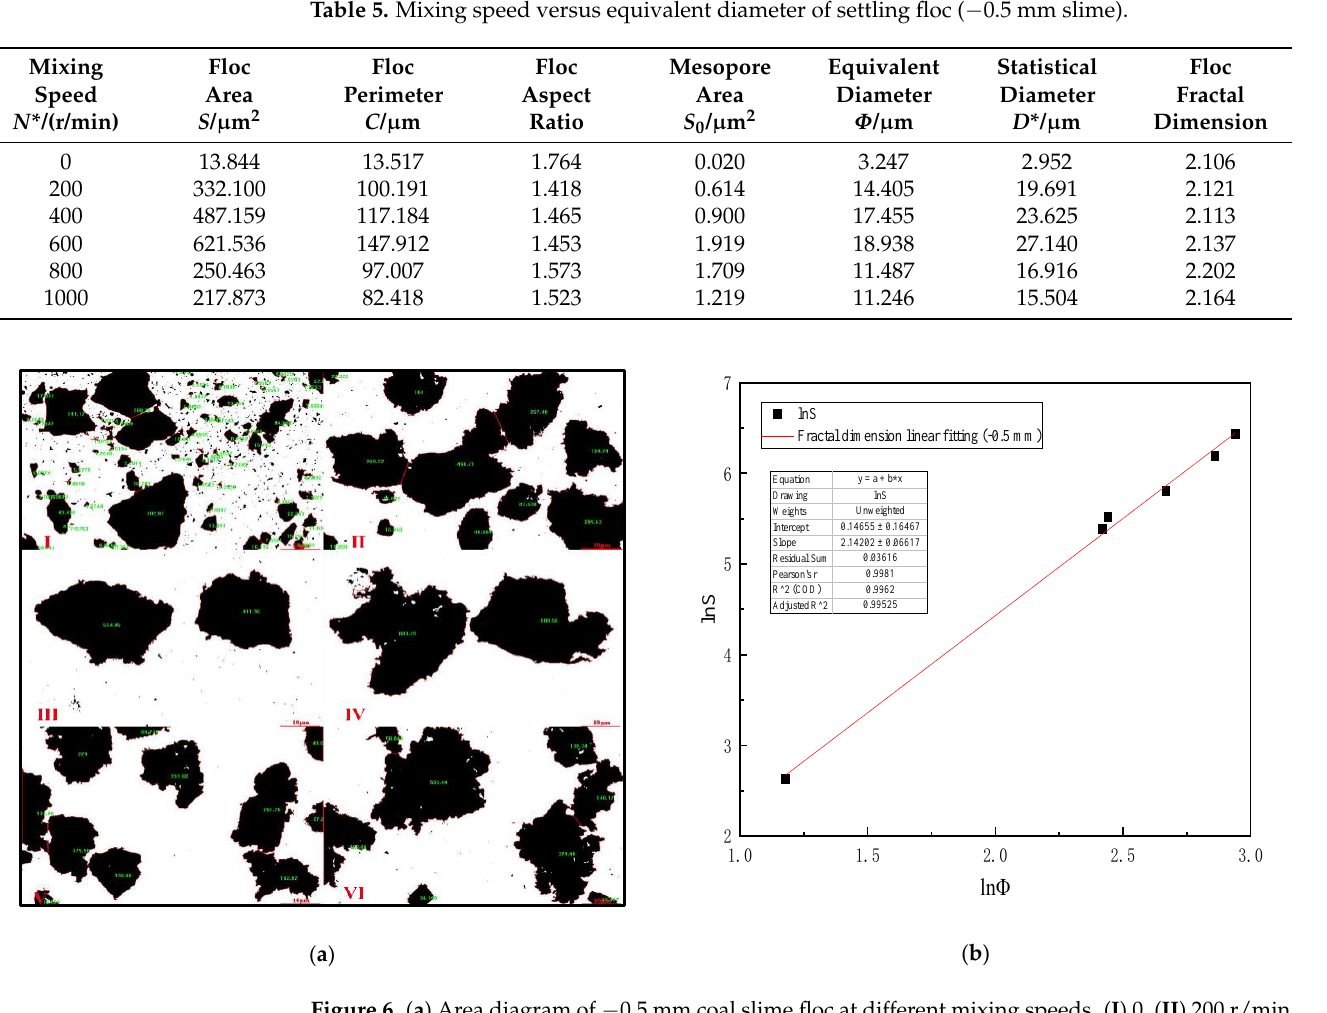
Figure 6. ( a ) Area diagram of − 0.5 mm coal slime floc at different mixing speeds. ( I ) 0, ( II ) 200 r/min, ( III ) 400 r/min, ( IV ) 600 r/min, ( V ) 800 r/min, ( VI ) 1000 r/min; ( b ) Fractal dimension fitting diagram of settling floc of − 0.5 mm coal slime. Table 6 is analyzed by Image-Pro-Plus 6.0 software and (Formulas (15) – (17)), which shows that when the mixing speed is 200 r/min, the equivalent diameter of 0.5 – 0.25 mm slime settling floc is the largest, and the settling speed of slime floc is the fastest on the microscopic level. Figure 7a is the analysis diagram of floc area of 0.5 – 0.25 mm slime at the mixing speed of 0 – 1000 r/min. Figure 7b shows the fractal dimension fitting diagram, when the mixing speed is 0 – 1000 r/min, the mean fractal dimension of 0.5 – 0.25 mm coal slime floc is 1.901.